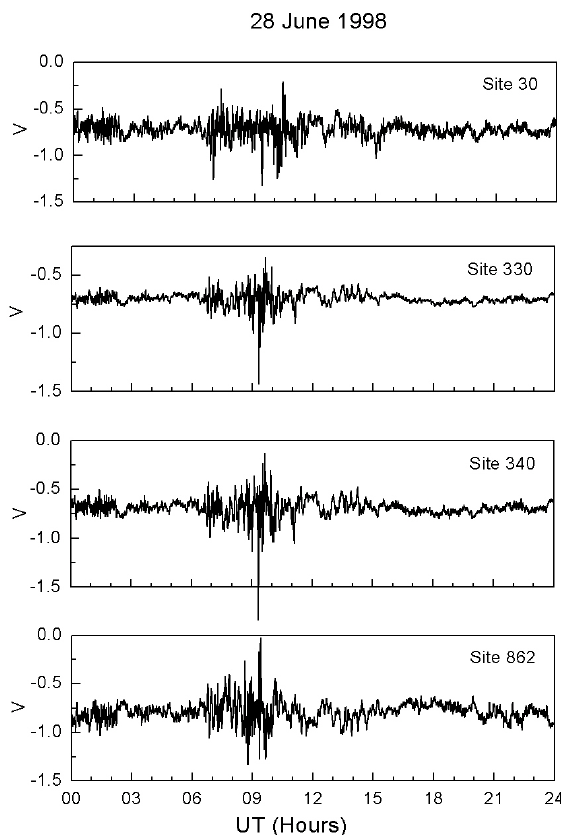
Fig. 12. Observed pipe-to-soil potential for different sites on the Norman Wells – Zama pipeline.